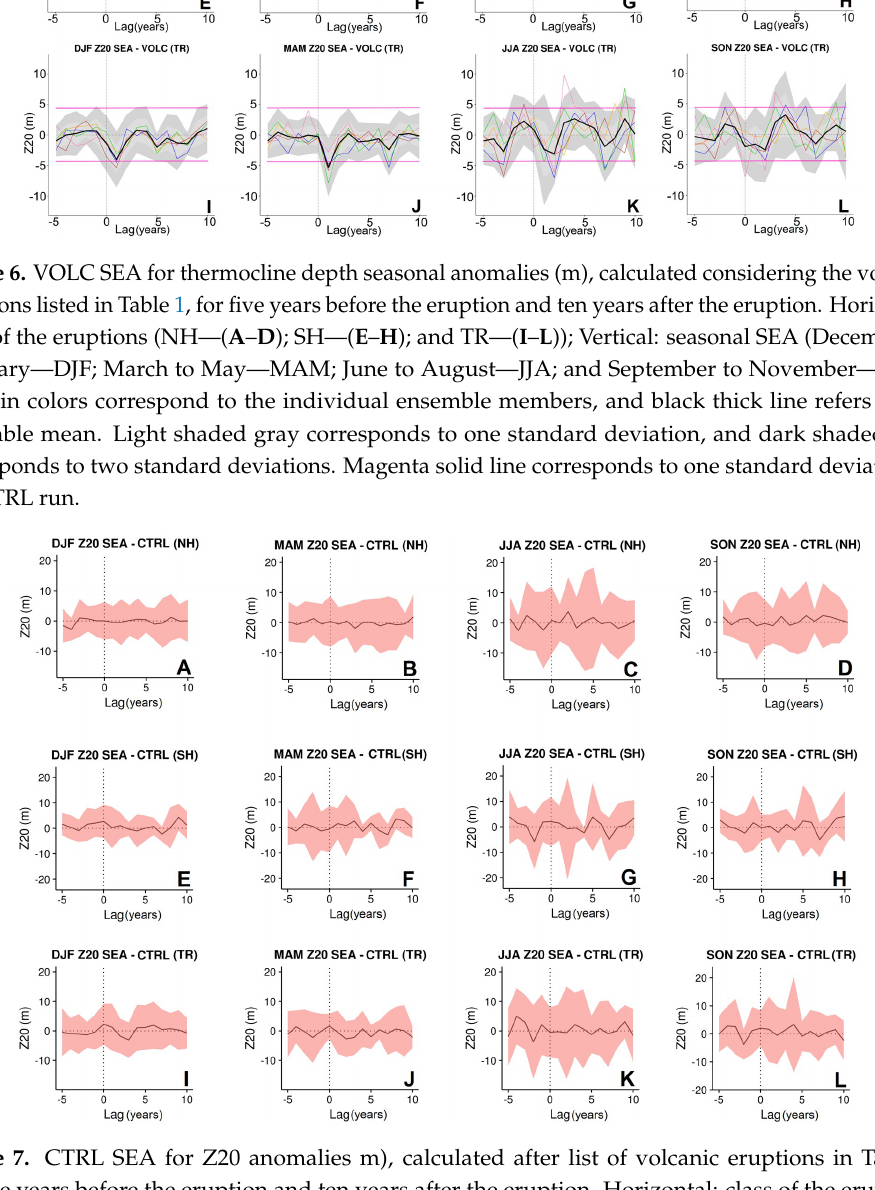
Figure 7. CTRL SEA for Z20 anomalies m), calculated after list of volcanic eruptions in Table 1, for five years before the eruption and ten years after the eruption. Horizontal: class of the eruptions (NH – A, B, C and D ; SH – E, F, G, and H ; and TR – I, J, K, and L ); Vertical: seasonal SEA (December to February – DJF; March to May – MAM; June to August – JJA; and September to November – SON). Dark red line corresponds to the CTRL run, and light shaded red corresponds to one standard deviation of the CTRL run.